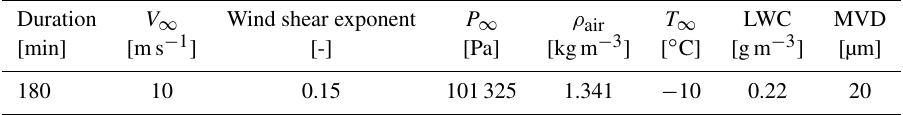
Table 2. Atmospheric conditions during the icing event studied. Duration V ∞ Wind shear exponent P ∞ ρ air T ∞ LWC MVD [ min ] [ ms − 1 ] [ - ] [ Pa ] [ kgm − 3 ] [ ◦ C ] [ gm − 3 ] [ µm ] 180 10 0.15 101325 1.341 − 10 0.22